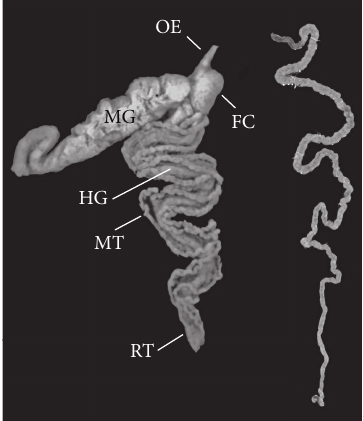
Figure 4: Mapuchea chilensis digestive tract with the Malpighian tubules and an isolated tubule (omitting the basal part entering the filter chamber). OE: oesophagus; FC: filter chamber; MG: midgut; MT: Malpighian tubules; and RT: